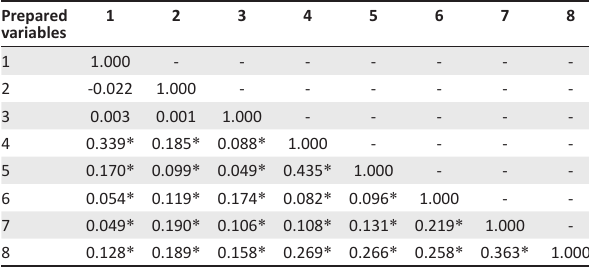
TABLE 4: Pearson correlation matrix of the prepared variables.